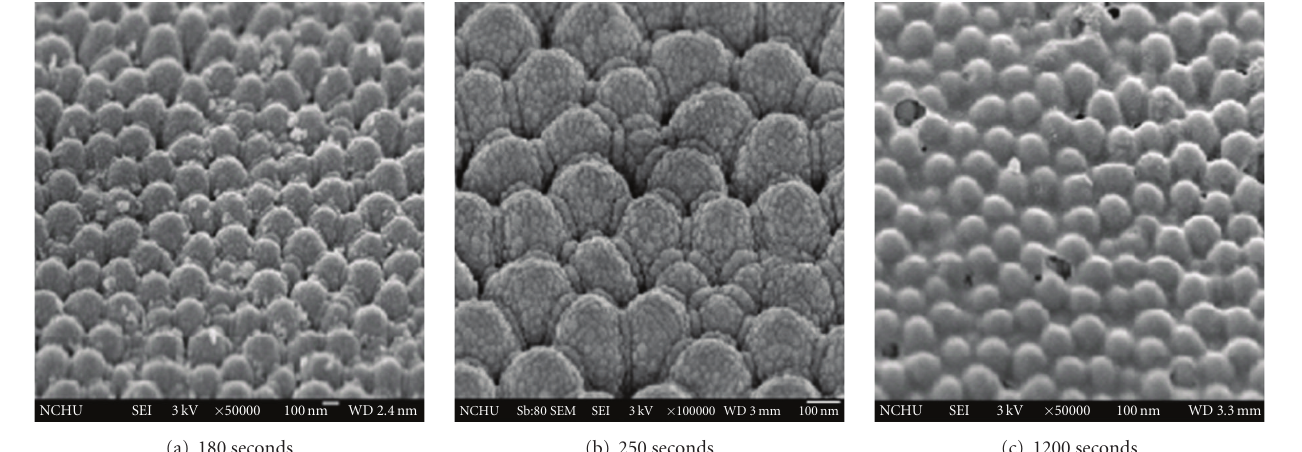
Figure 6: SEM images of nano-hemispheric TiO 2 /ITO/AAO electrodes after various deposition durations.